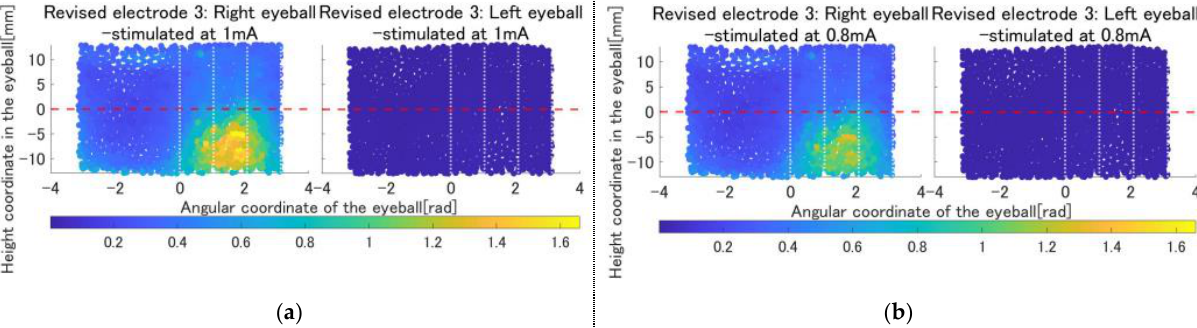
Figure 10. Simulation results with revised electrodes that locally stimulate the lower central area of the eyeball surface: ( a ) simulation result using revised electrode 3 at 1 mA; ( b ) simulation result using revised electrode 3 at 0.8 mA.